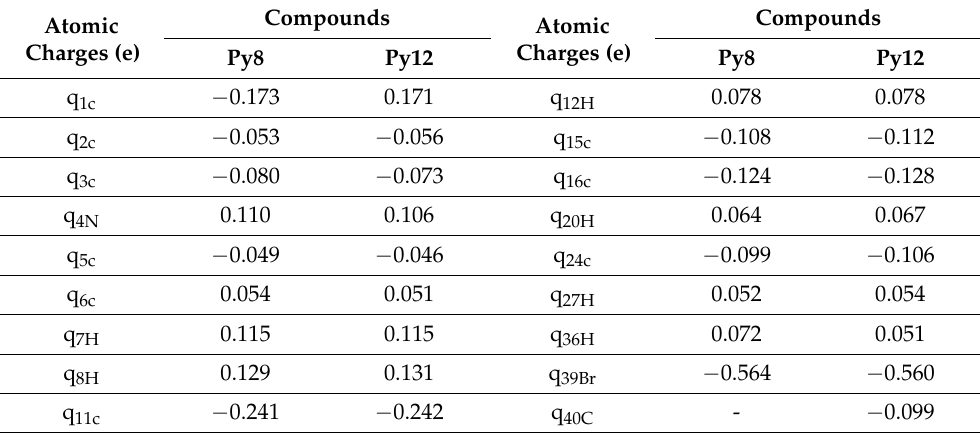
Table 9. Selected Mulliken atomic charges on the corrosion inhibitors Py8 and Py12 calculated in vacuum at PBE/def2-TZVPP level of